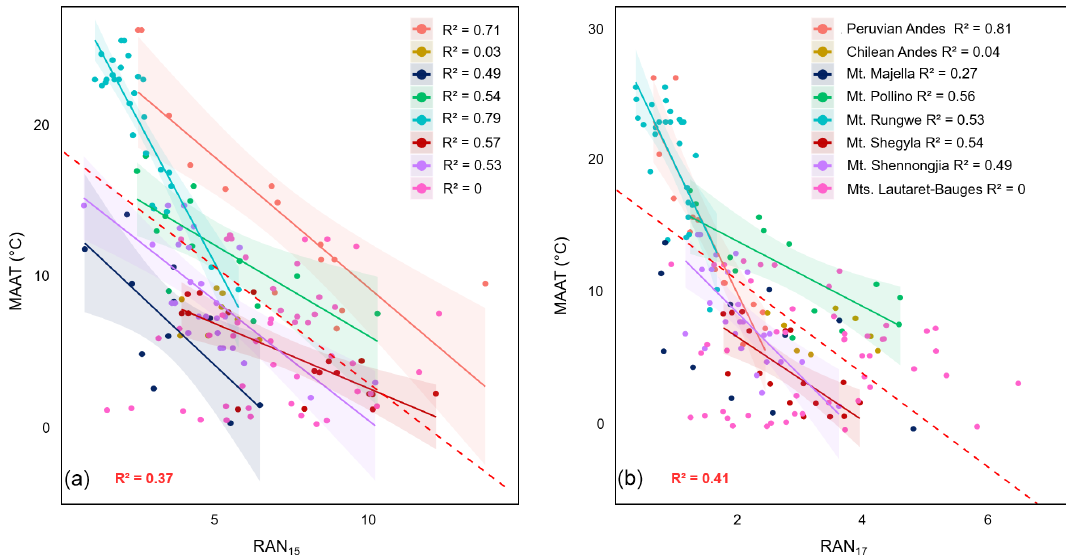
Figure 5. Linear regressions between (a) MAAT and RAN 15 and (b) MAAT and RAN 17 along the eight altitudinal transects investigated. Dotted lines represent the 95% confidence interval for each regression, and coloured areas represent the 95% confidence interval for each regression. Data from Mt. Majella and Mt. Rungwe were taken from Huguet et al. (2019). Data from Mt. Shennongjia were taken from Wang et al. (2016). Data from Mt. Bauges and Mt. Lautaret-Galibier were taken from Véquaud et al. (2021). Only significant regressions ( p < 0 . 05) are